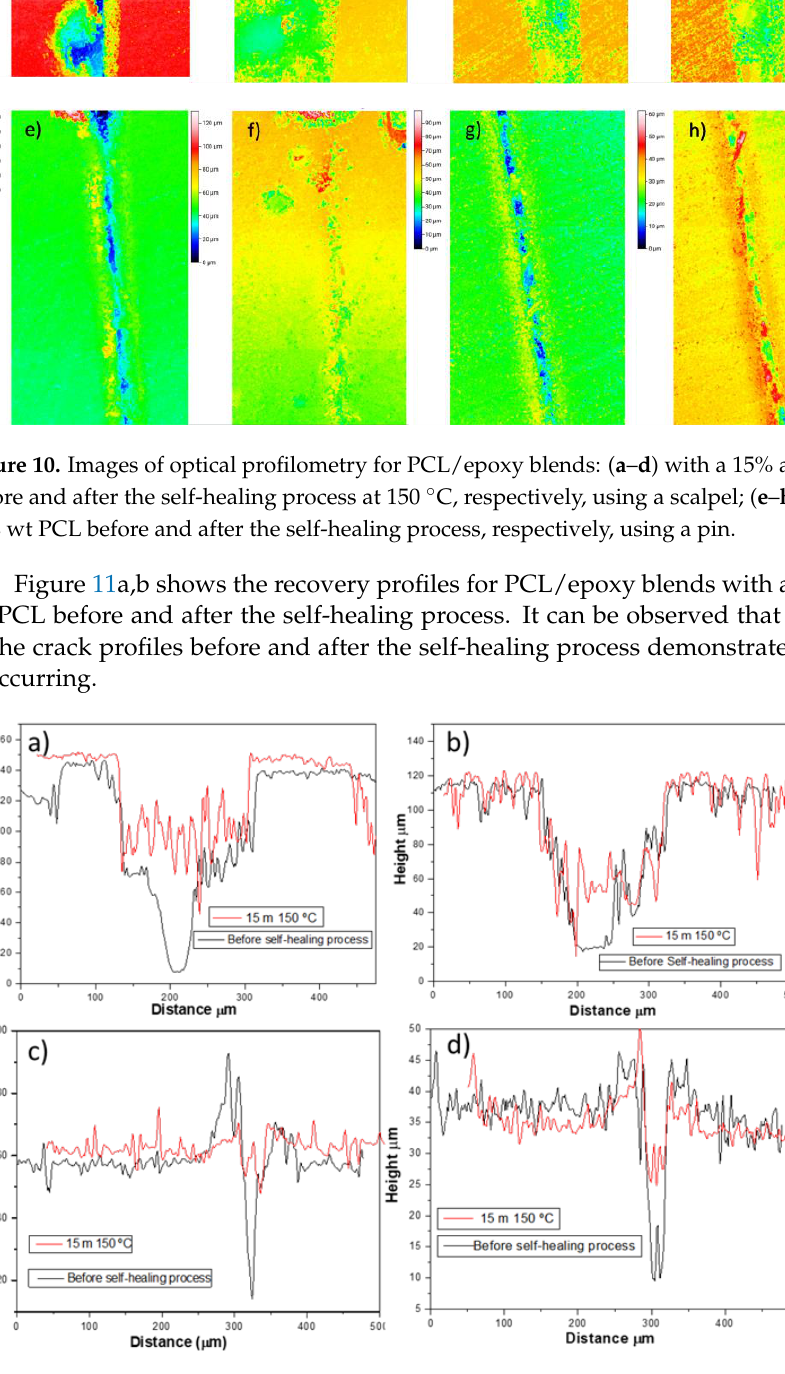
Figure 11. Recovery profile for PCL/epoxy blends: ( a ), ( b ), ( c ), ( d ) with a 15% and 10% wt PCL before and after the self-healing process at 150 °C, respectively, using a scalpel; ( e ), ( f ), ( g ), ( h ) with 15% and 10% wt PCL before and after the self-healing process, respectively, using a pin.